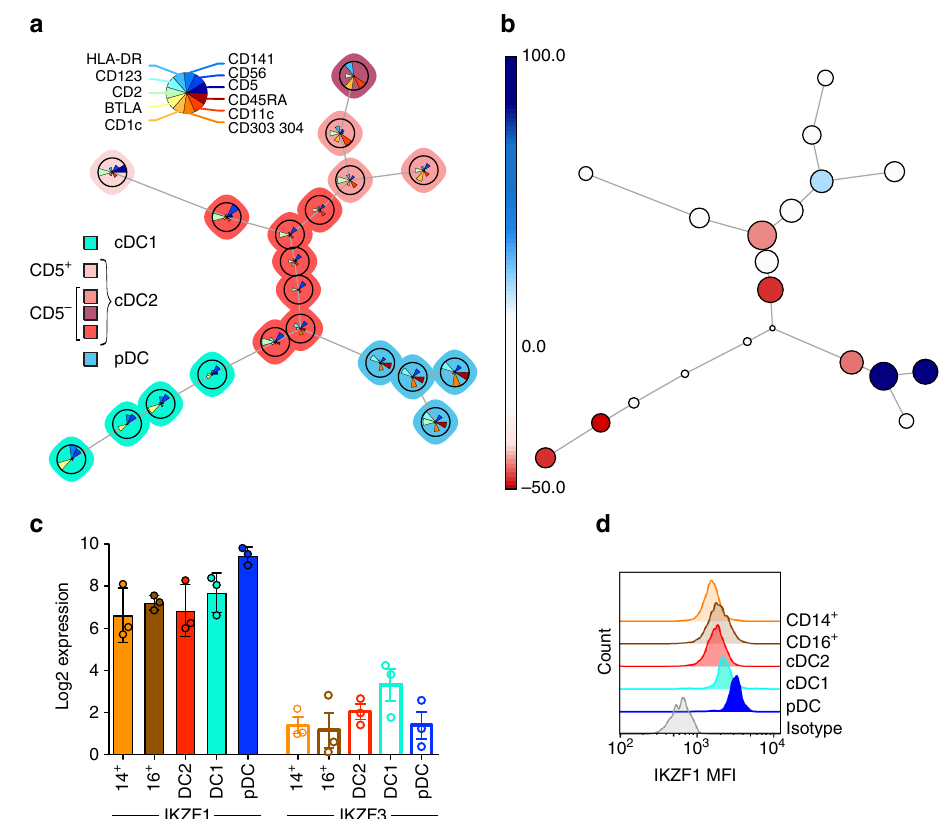
Fig. 1 FlowSOM analysis of PB reveals a reduced proportion of pDC but increased cDC1 in a patient carrying IKZF1 mutation. a Minimal spanning tree visualisation of a self-organising map using compensated fl ow cytometric data from a family B member (B5) compared to a travel control (equal number of events). Data were taken from the lineage (CD3, CD7, CD14, CD16, CD19, CD20)-negative HLA-DR-positive gate. FlowSOM nodes represent clusters of cells. Metaclusters of the nodes, determined by the map, are represented by the background colour of the nodes. Star charts represent the mean marker value of cells in that node with the height of each part corresponding to marker intensity. b Comparison between samples used to generate the map; size of nodes represents proportional number of cells in each node, colour represents proportional differences between samples with red and blue indicating higher or lower numbers in IKZF1 mutation compared to wild type, respectively. c mRNA and d protein expression of IKZF1 in healthy donor monocytes and dendritic cells by NanoString gene expression analysis of FACS sorted cells or intracellular fl ow cytometry, respectively ( n = 3 donors for each experiment). IKZF3 mRNA expression is shown for comparison in c . cDC1/2, conventional dendritic cell 1/2; pDC, plasmacytoid dendritic cell; 14 + CD14 + ,